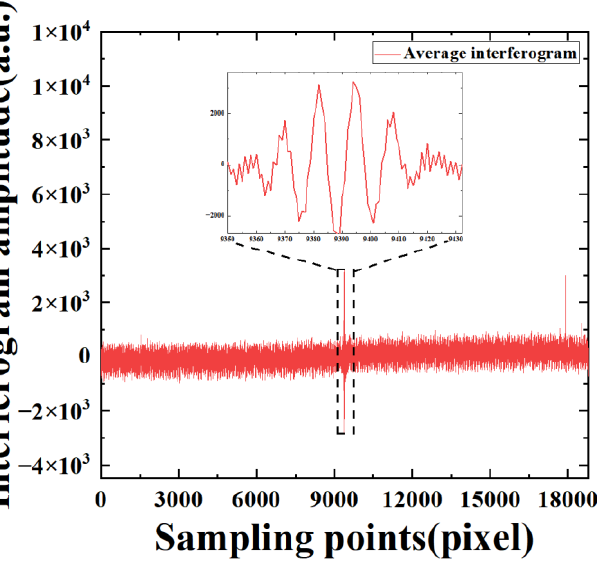
Figure 4. Amplitudes of the interferogram as a function of sampling points for the average interferogram of the 747th pixel at a sampling frequency of 80 MHz.